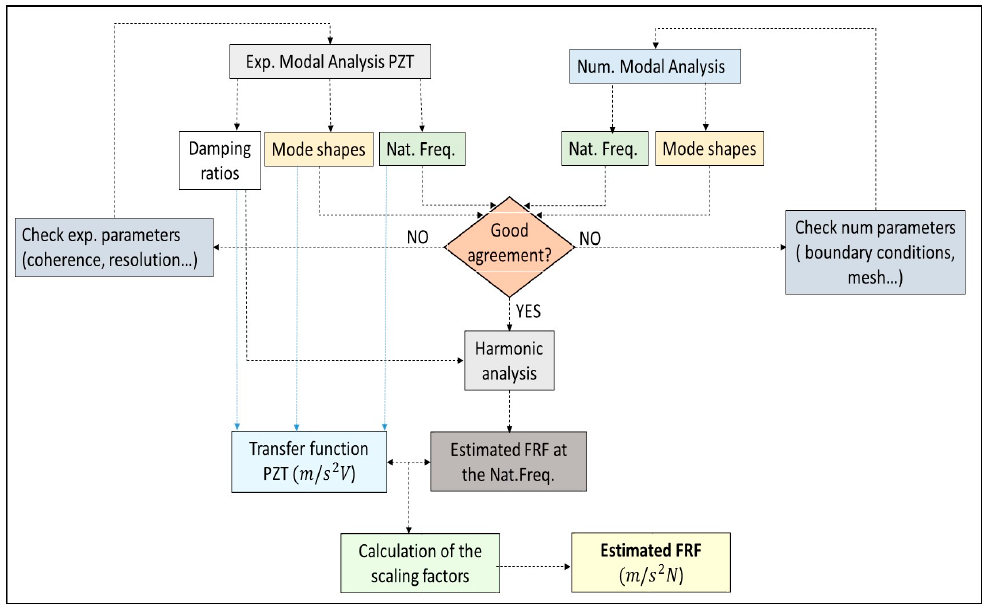
Figure 11. Flowchart of the proposed method to estimate the FRF using PZTs and a numerical simulation model. Table 3. Validation of the numerical model. Comparison of the natural frequencies and mode shapes. Numerical Modal Analysis vs. Experimental Modal Analysis with PZT.